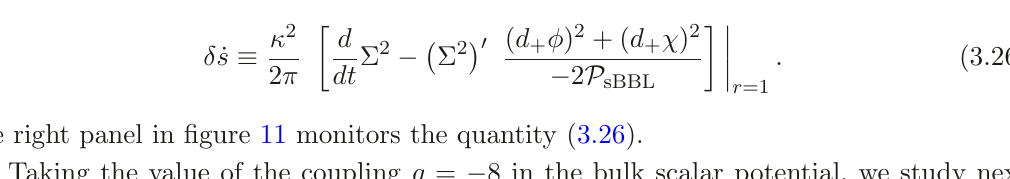
and operators in sBBL model with g = O i O r < crit . Different color coding represents different spatial E E